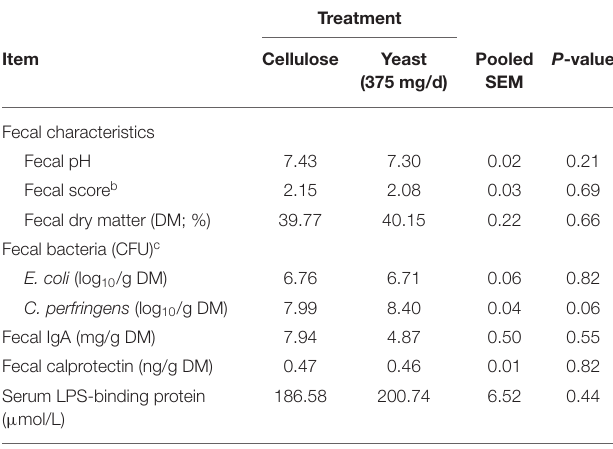
TABLE 6 | Fecal characteristics, fecal bacteria counts, fecal IgA, fecal calprotectin, and serum lipopolysaccharide (LPS)-binding protein of yeast- or cellulose-supplemented dogs before diet transition (day 13 or 14) a